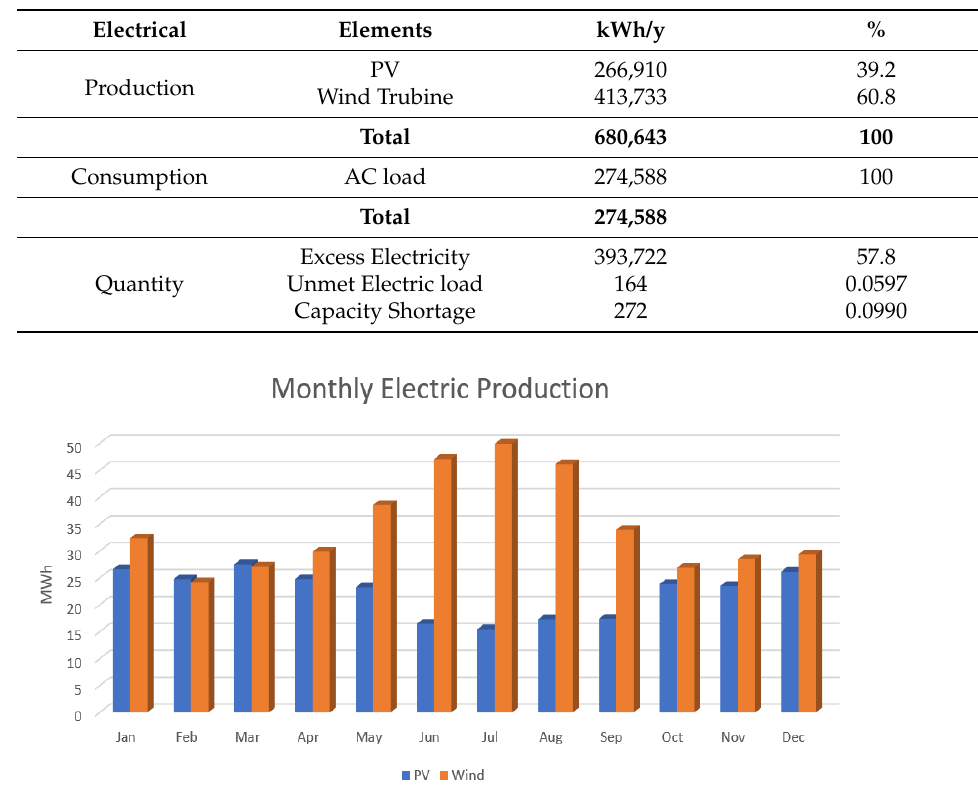
Table 5. Augmented Electrical Result for PV/Wind/Battery.